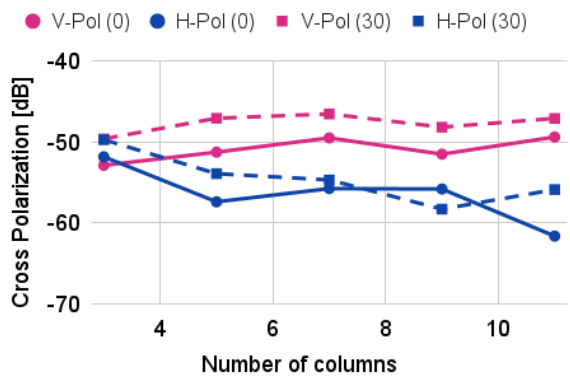
FIGURE 15: Cross-polarization level for different scan an- gles for the 2X20